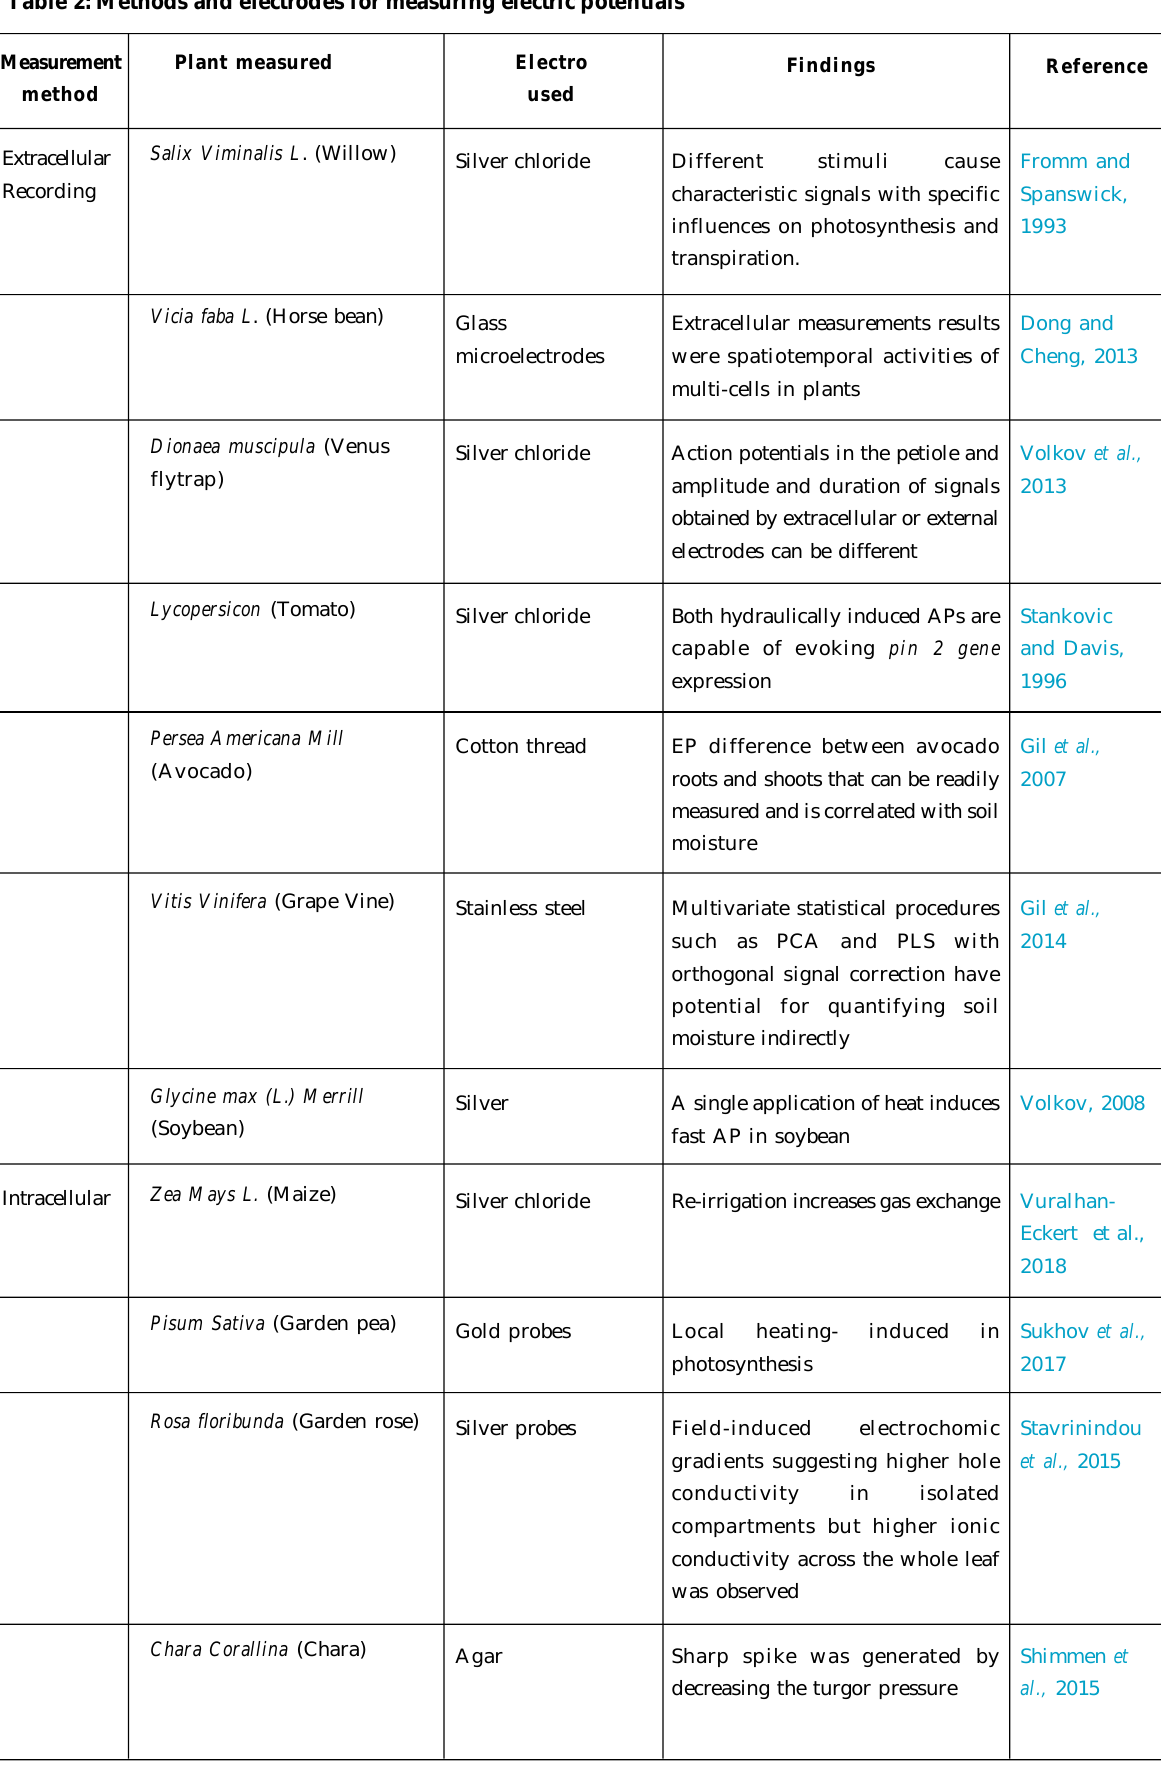
Table 2: Methods and electrodes for measuring electric